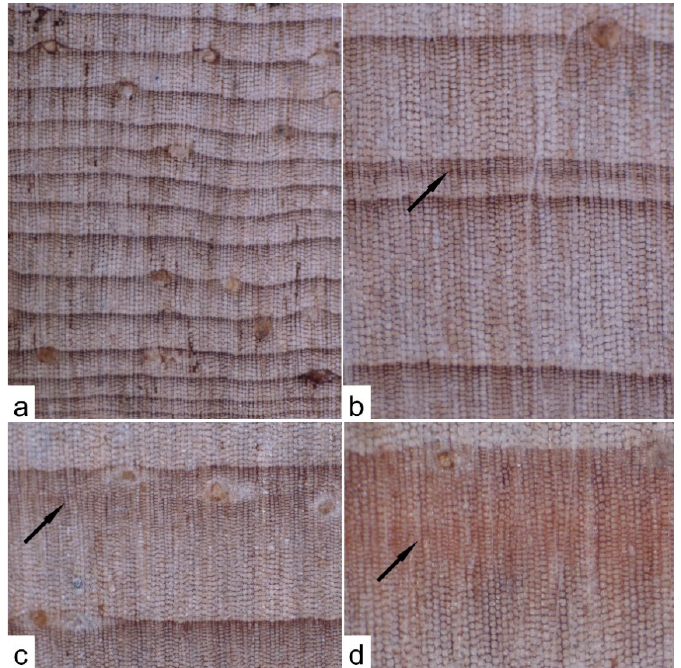
Figure 9. Growth characteristics and growth anomalies observed in the timber from Gönpa Gang: ( a ) arrangement of the resin canals, mainly in the latewood; ( b ) false ring (intra-annual density fluctuation—IADF) detected within the 41st ring of sample no. UMGG09; ( c ) IADF detected in the 15th ring of sample no. UMGG06; ( d ) IADF detected in the 38th ring in sample no. UMGG10. From the 14 samples collected in Gönpa Gang, 18 series were worked out. Since cores no. UMGG02, UMGG03, UMGG06, and UMGG13 contain a sufficient number of rings on both sides of the pith, two sequences were measured for each of them. Hence, 15 series from 12 samples were synchronized and used for the development of the mean chronol- ogy, UMGG_m, with a total length of 160 rings (Figure 10). The samples not included in